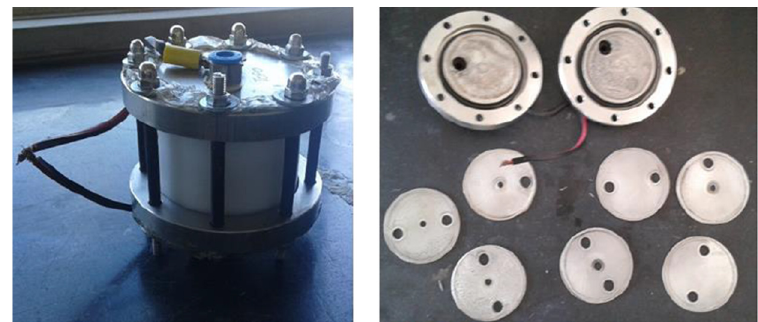
Figure 2. Glass reactor used with liquified biomass to produce methane.